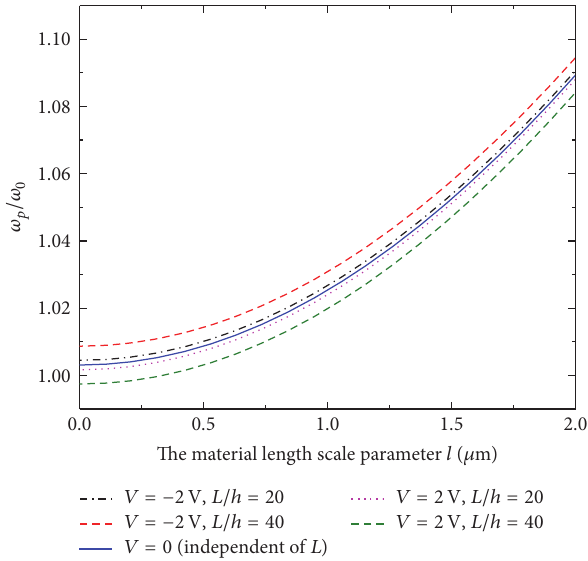
Figure 4: 𝑙 -dependence of 𝜔 𝑝 /𝜔 0 obtained for PMBs where the effectofpiezoelectricityisconsideredbuttheeffectofflexoelectricity is ignored. Here PMBs have ℎ = 10𝜇 m and 𝐿/ℎ = 20 and 40,